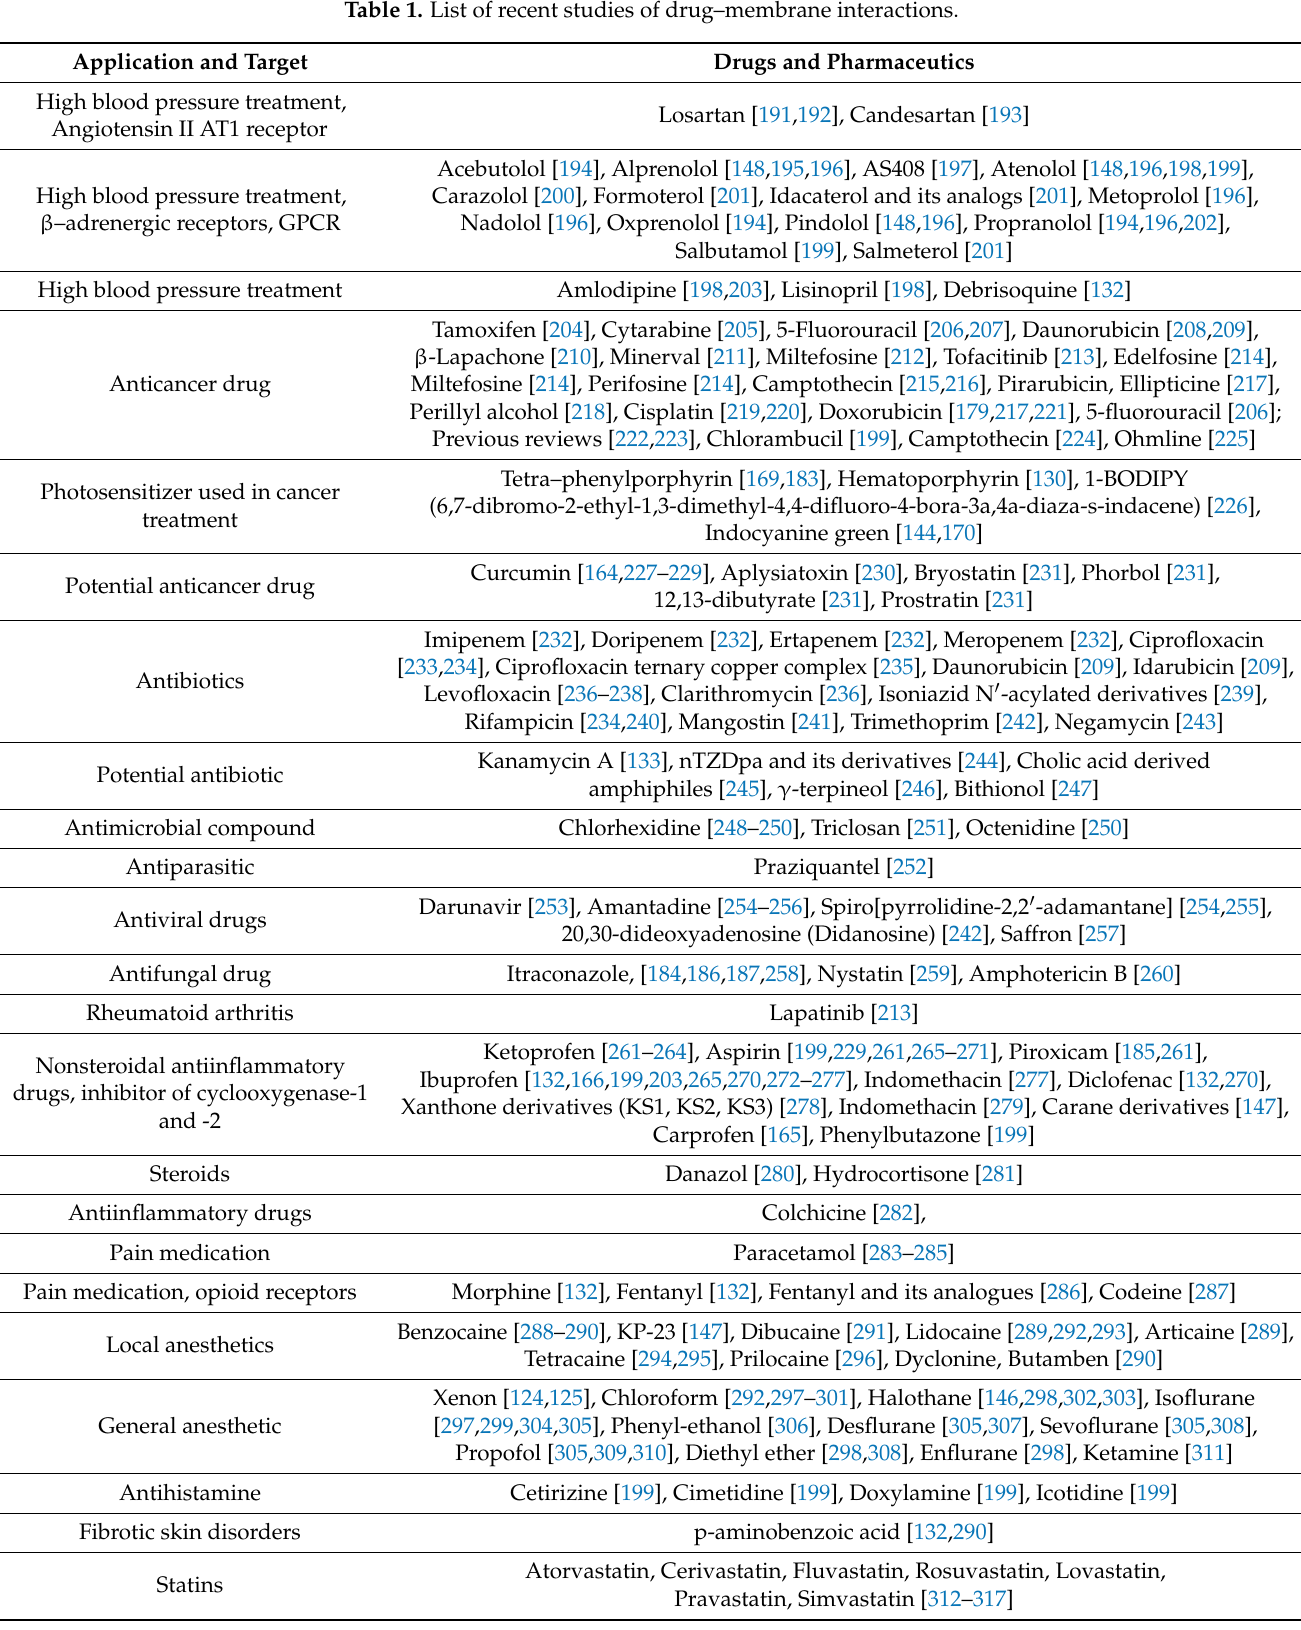
Table 1. List of recent studies of drug–membrane